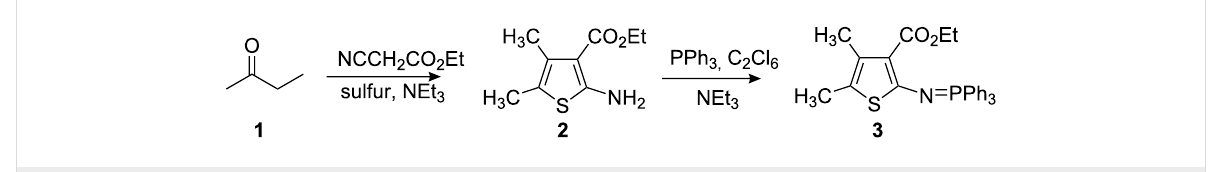
Scheme 1: Preparation of iminophosphorane 3 .